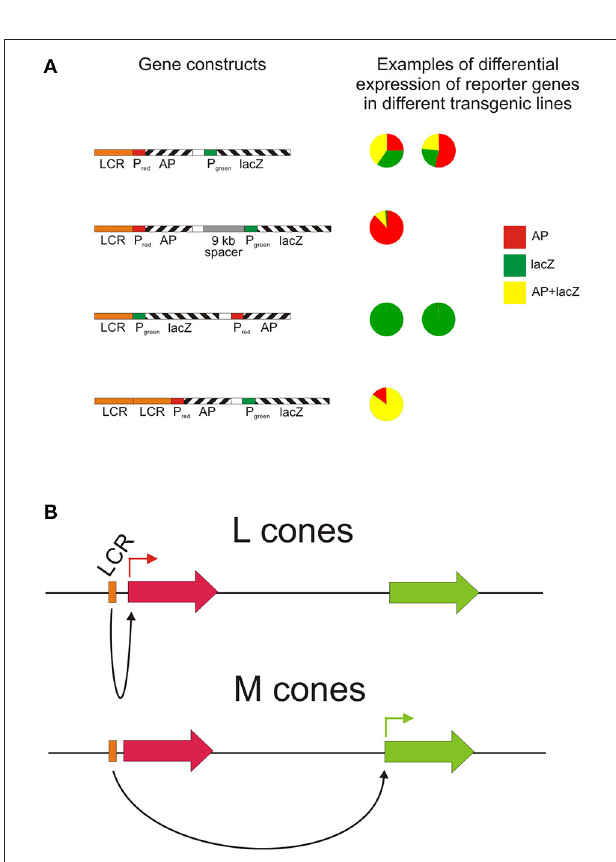
FIGURE 2 | The role of the LCR in directing reporter gene expression from L and M opsin gene promoters. (A) The relative activity of the L and M promoters in four different transgene arrays assessed in a number of transgenic mouse lines by scoring individual cone cells for the expression of the reporter genes. P L , human L opsin gene promoter; P M , human M opsin gene promoter; AP, human placental alkaline phosphatase; lacZ, E. coli β -galactosidase. Re-drawn from Smallwood et al. (2002). (B) Potential mechanism for the stochastic expression of L or M opsin genes via LCR-opsin gene promoter